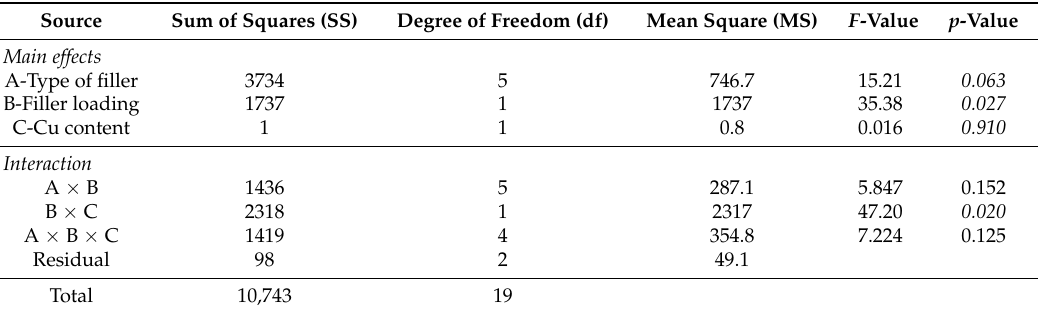
Table 7. ANOVA for parameter elongation at break (%).